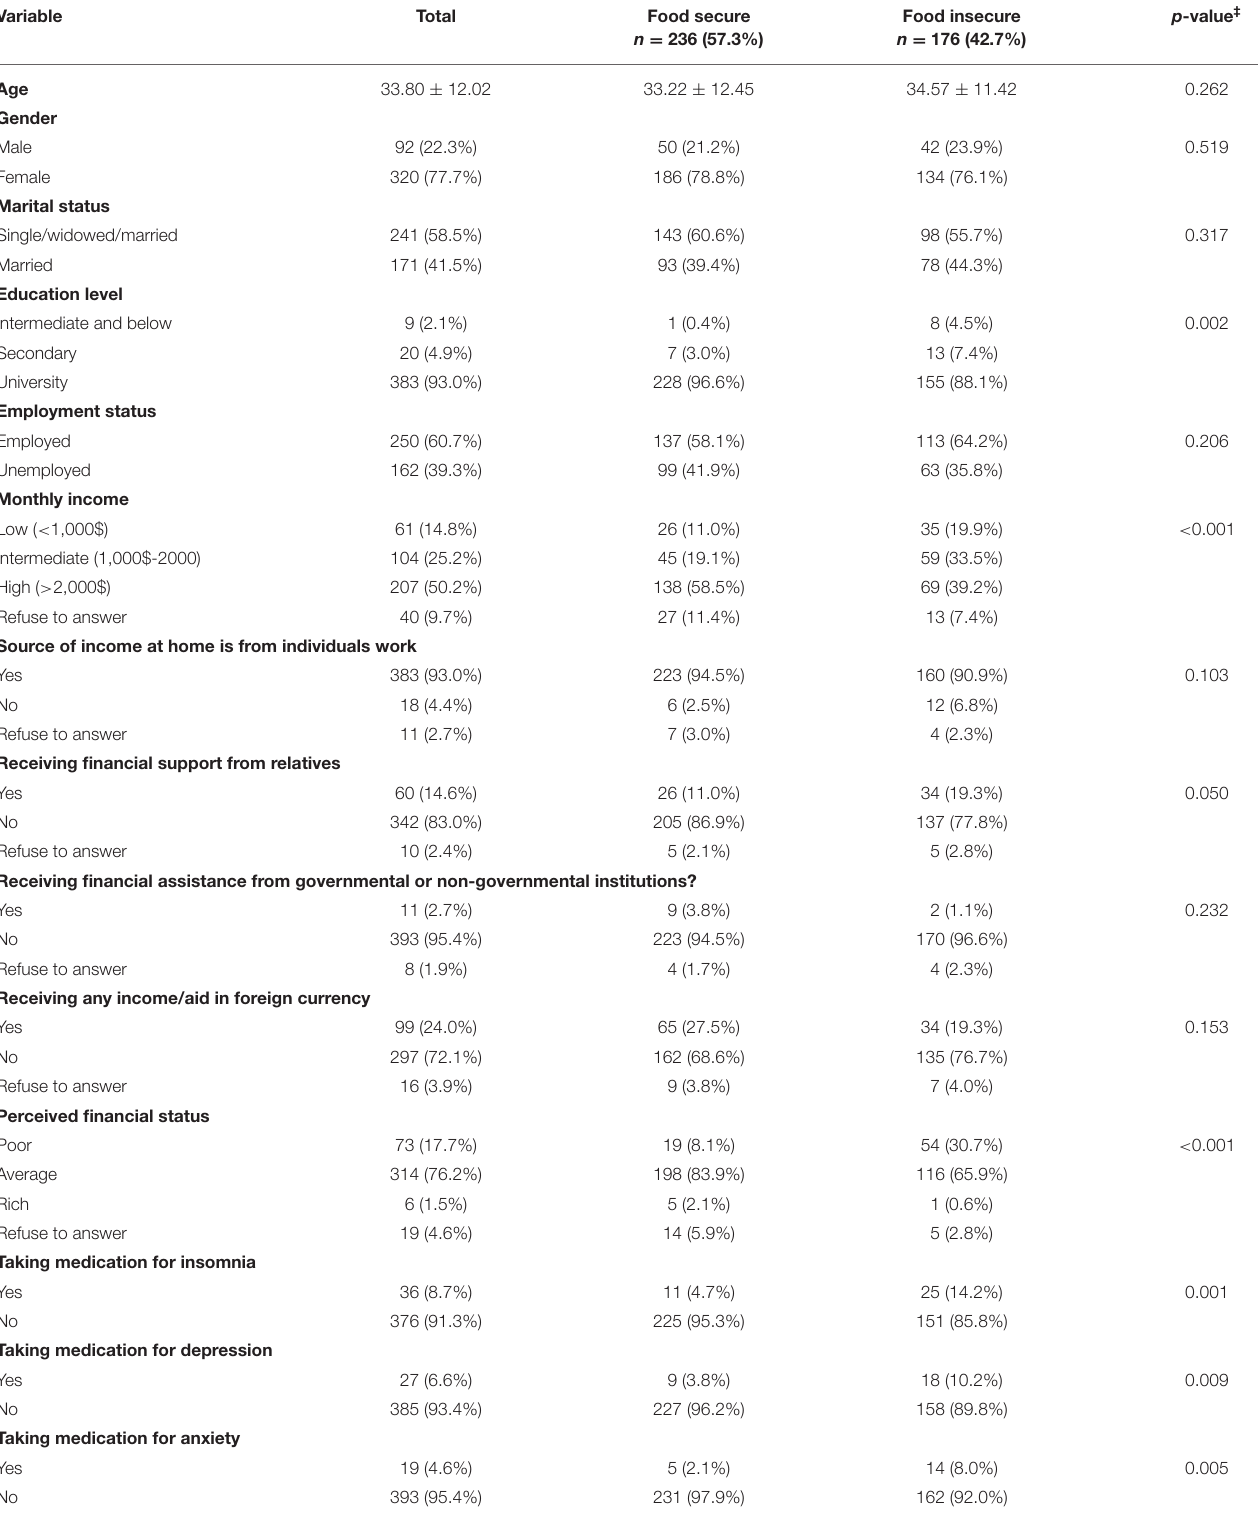
TABLE 1 | Socio-demographic, economic, and other descriptive characteristics of the study participants ( N = 412) † .